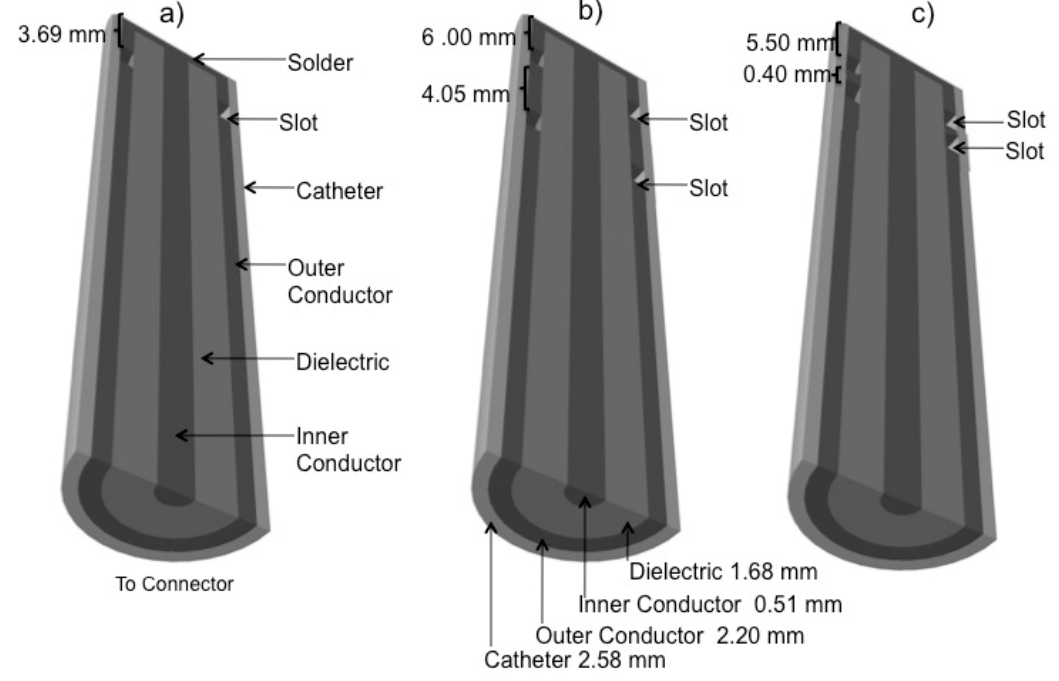
Figure 1. Coaxial Slot Antennas. ( a ) Single slot antenna; ( b ) Double slot antenna; ( c ) Double “short-distance” slot antenna.